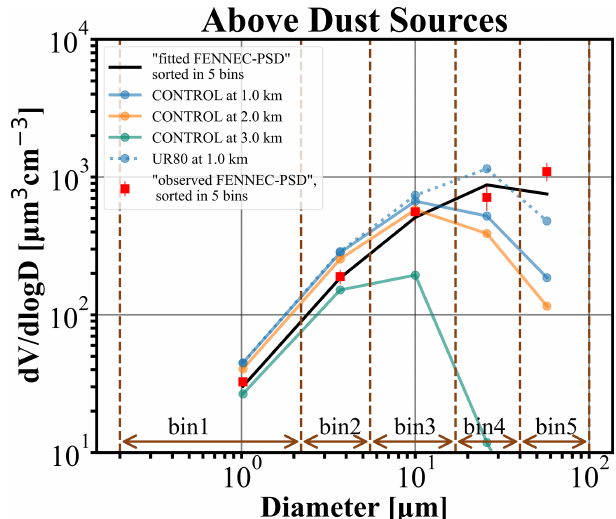
Figure 5. Dust size distribution above an emission model grid point (latitude = 24.9 and longitude = 9.2 ◦ ) in Mali on 11 August 2015 at 14:00UTC. Blue solid line: the dust PSD of the CONTROL run in- terpolated at 1km altitude above the dust source, orange solid line: the dust PSD of the CONTROL run interpolated at 2km altitude above the dust source, green solid line: the dust PSD of the CON- TROL run interpolated at 3km altitude above the dust source, blue dotted line: the dust PSD of the UR80 run interpolated at 1km al- titude above the dust source, red squares: the “observed FENNEC- PSD” at 1km altitude (sorted into five bins), and black squares: the “fitted FENNEC-PSD” at 1km (sorted into five bins) which has been used for the distribution of the model emission to the five size